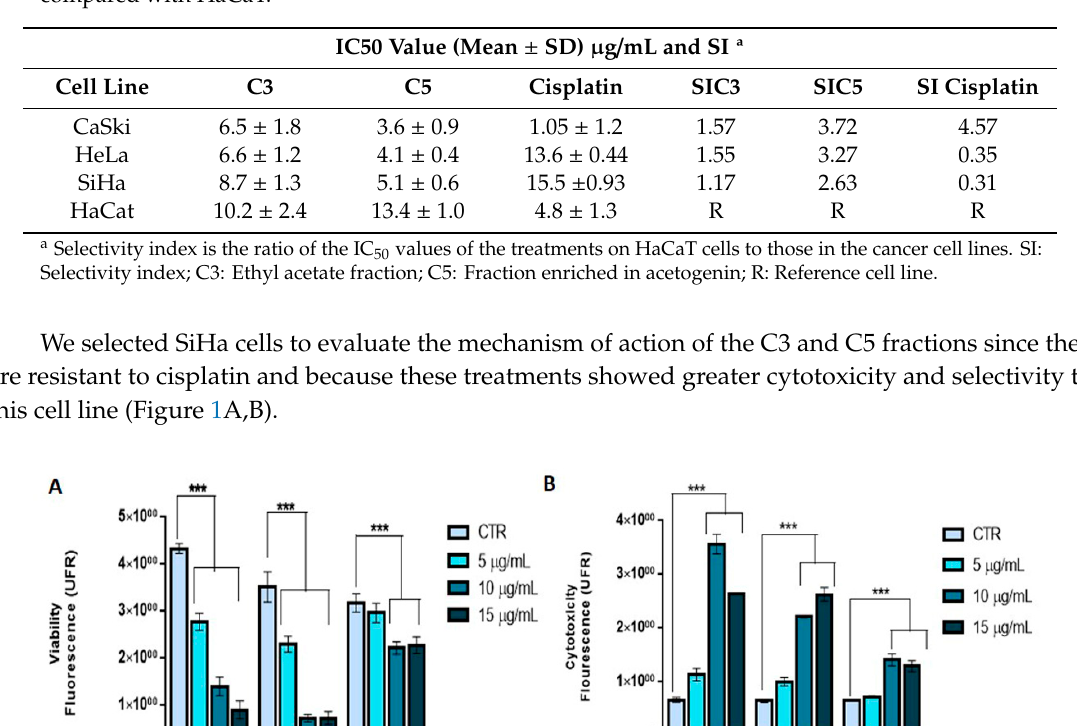
Table 3. IC 50 values and selectivity index for the C3 and C5 fractions of cisplatin to tumor cells as compared with HaCaT.